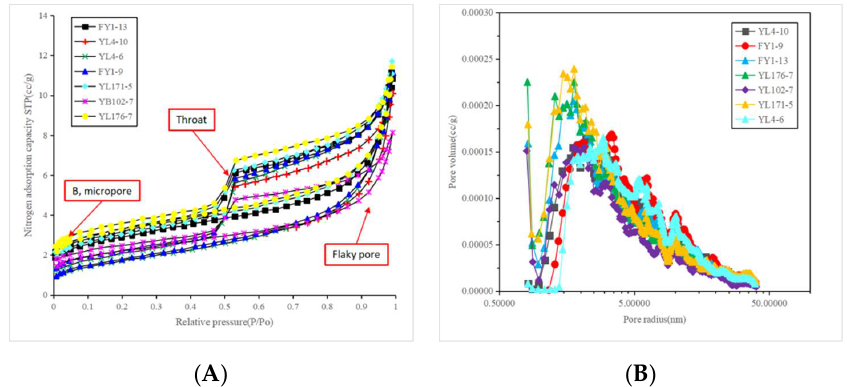
Figure 5. N 2 adsorption and desorption curve ( A ) and pore size distribution of shale N2 adsorption NLDFT model ( B ).